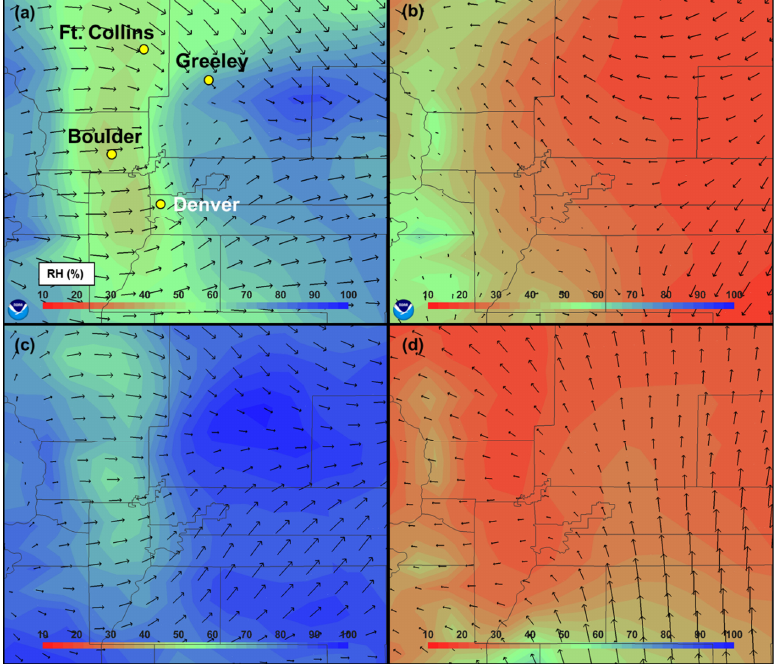
Figure 2. RAP model analysis runs at 13km resolution for (a, b) 26 July 2014 (12:00UTC (05:00MST), 21:00UTC (14:00MST), re- spectively) and (c, d) 2 August 2014 (12:00, 21:00UTC, respectively). Arrows show surface wind vectors, while the color scale represents surface RH.